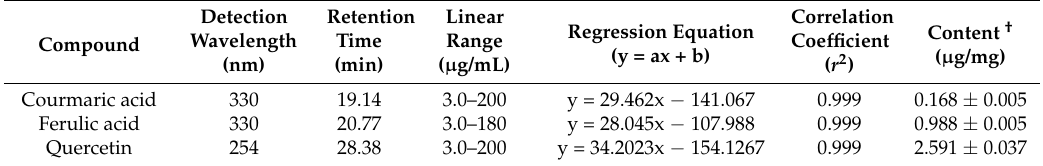
Figure 1. Fingerprinting analysis of A. fistulosum root extract and three reference compounds for coumaric acid, ferulic acid, and quercetin at ( A ) 330 nm, and ( B ) 254 nm, respectively. Table 2. Linearity, retention time of three reference compounds, and the contents of A. fistulosum root